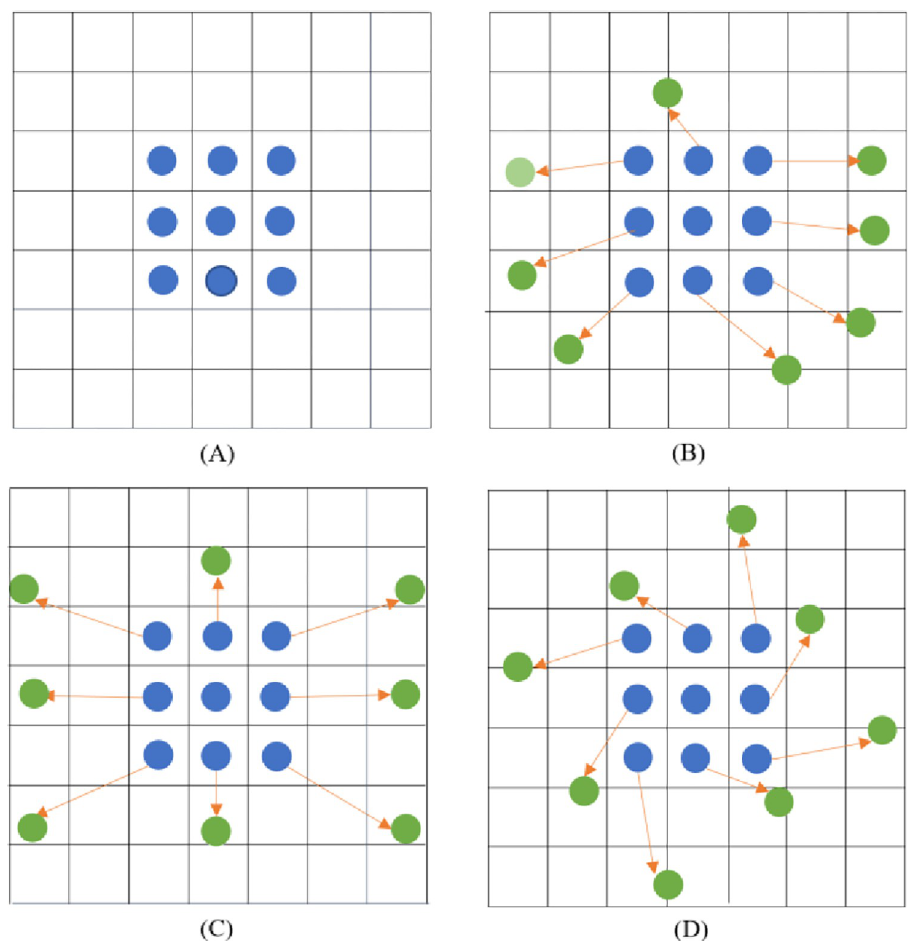
Fig 3. Three typical cases of convolution kernel shifting of conventional convolution. Group A is the conventional distribution, Group B is the distribution after arbitrary migration, Group C is the distribution after scaling transformation and Group D is the distribution after rotational